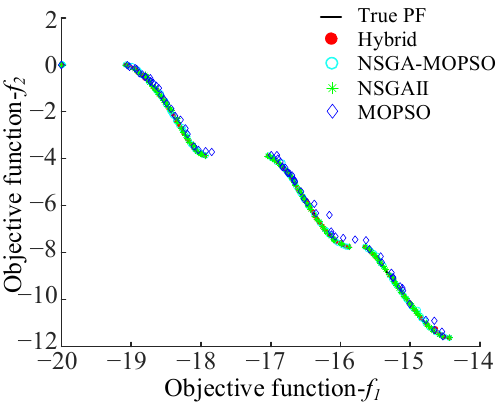
Figure 2. Comparison results for KUR.